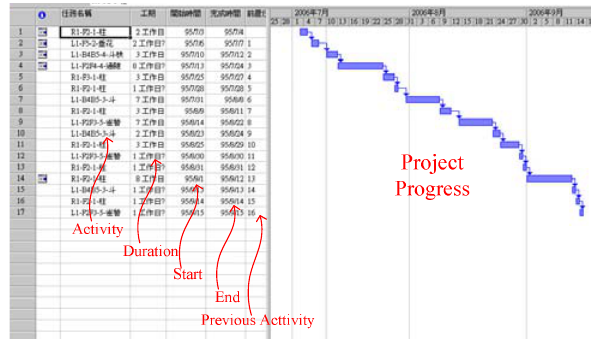
Fig. 15. Application of MS